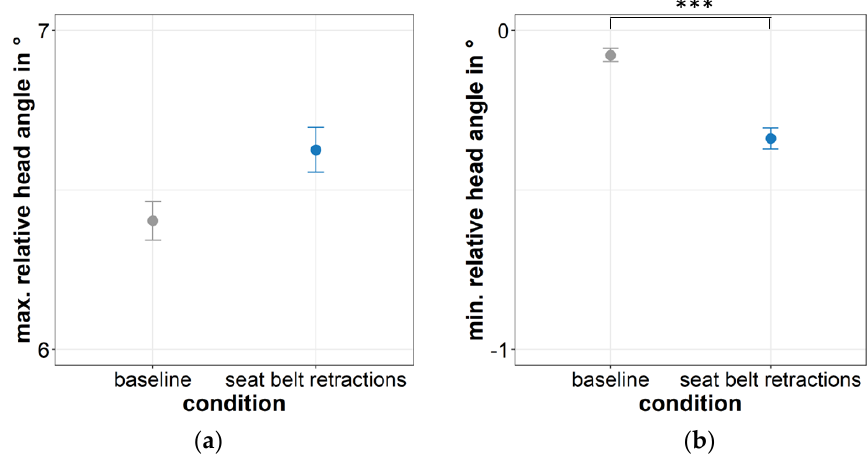
( b ) Figure 13. Distribution of mean neck muscle tension during the braking maneuvers in the baseline and with seat belt retractions: ( a ) EMG1; ( b ) EMG2. * p < 0.05. 3.4. Head Movements